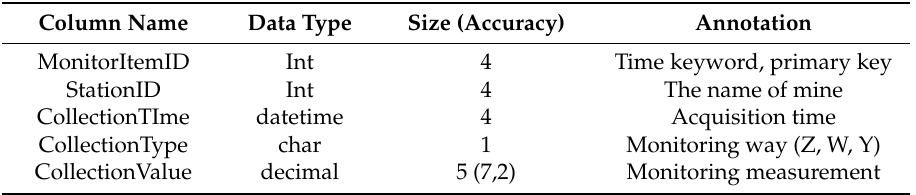
Table 2. MonitorItem fact table properties.